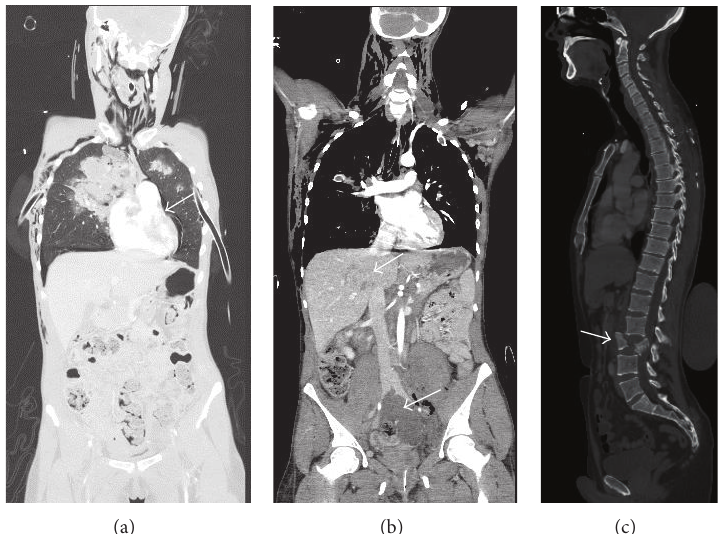
Figure 1: 25-year-old female patient with a heavy trauma falling from a roof with suicidal intention. Image acquisition with the CT ASIR 40 protocol. (a): coronal orientation/lung window showing bilateral pneumothoraces (arrow) with B¨ulau drains in situ, heavy contusion in both lungs, and extensive thoracal and cervical soft tissue emphysema. (b): coronal orientation/soft tissue window showing hypodensities in terms of an acute liver haematoma in the right lobe (arrow). Also note a huge retroperitoneal haematoma in the lower abdomen (arrow). (c): another male 42-year-old patient after falling from a roof. CT ASIR 40 protocol, sagittal plane/bone window. Vertebral body fracture in L3 with consecutive spinal stenosis